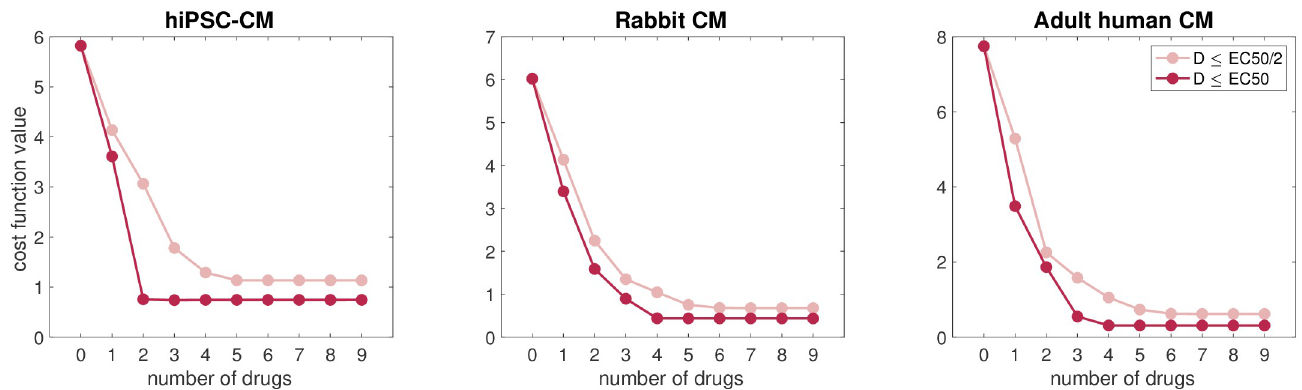
Fig 6. Optimal cost function values obtained when our computational procedure is applied to combinations of an increasing number of drugs applied simultaneously with the goal of repairing the SQT1 mutation in hiPSC-CMs, rabbit ventricular CMs and adult human ventricular CMs. These computations were done applying the restrictions D � min(EC 50 )/2 (pink) and D � min(EC 50 ) (red) for the drug doses. Data used in this figure can be found in S1 Data.